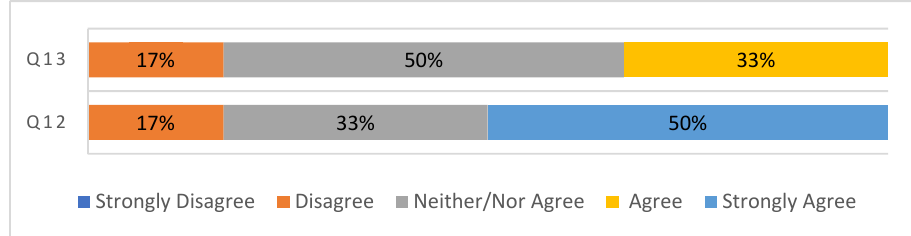
Figure 22. Distribution of answers to post-test questionnaire: behavior layer.